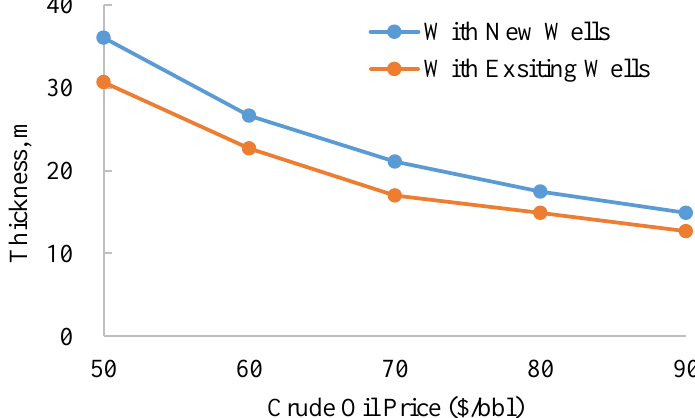
Figure 1—Limit of effective thickness in alkaline surfactant polymer flooding of class III reservoir.